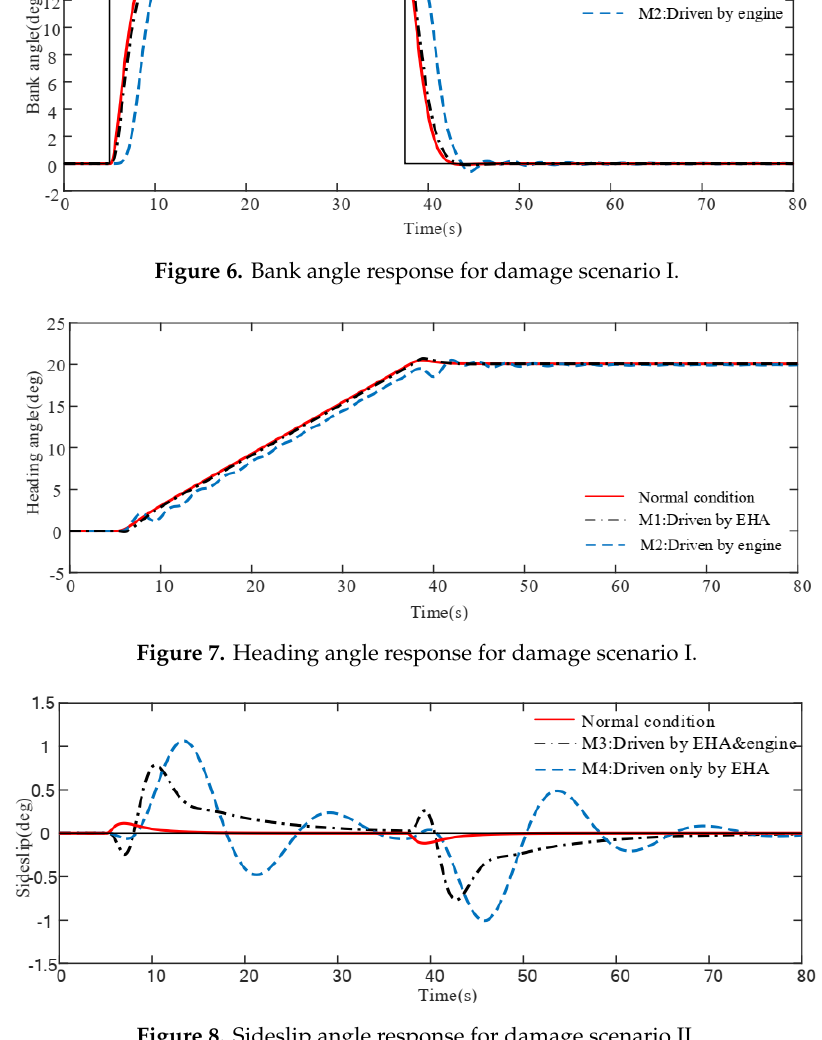
Figure 8. Sideslip angle response for damage scenario